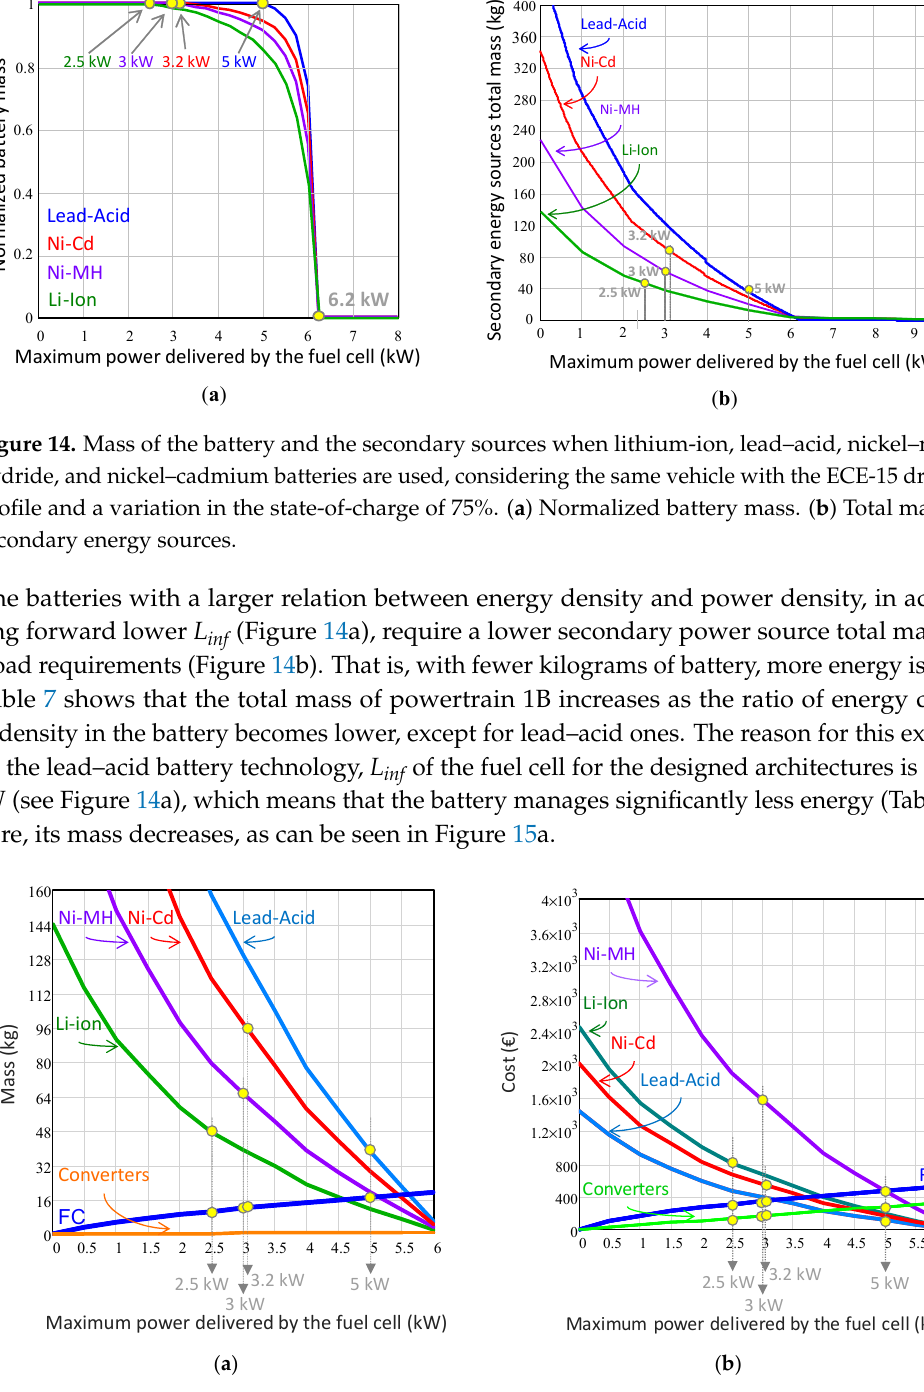
Figure 15. The fuel cell system and the converter of powertrain 1B with different battery technologies, with a variation in the state-of-charge of 75%, when the ECE-15 driving profile is applied. ( a ) Mass. ( b ) Cost.